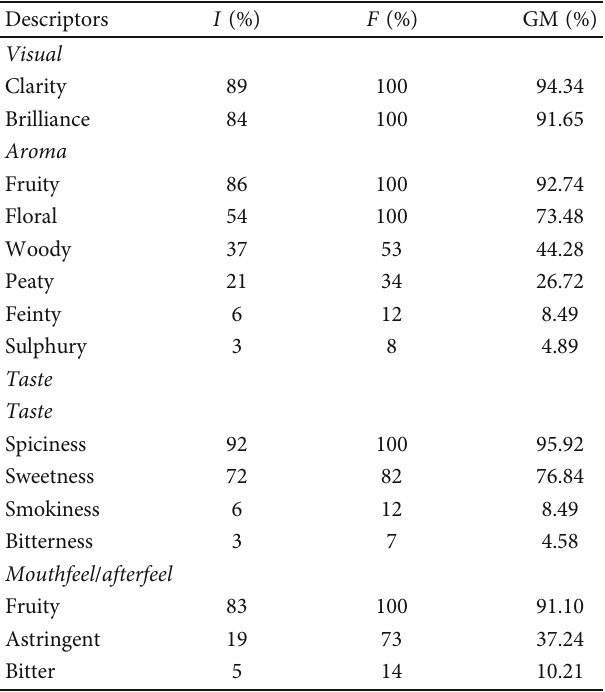
Table 5: Sensory characteristics of pepper